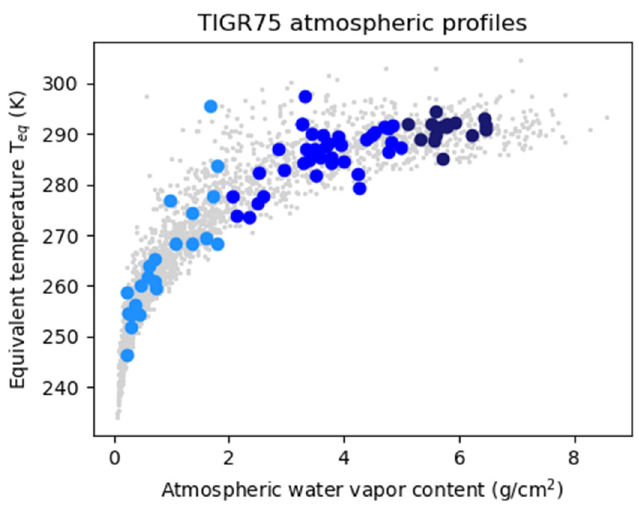
Figure 8. Distribution in the equivalent temperature ( 𝐓 𝐞𝐪 ) and AWVC plan of the TIGR profiles. The grey dots show the original 2311 TIGR profiles, and the blue ones the 75 used in this study. The three shades of blue show water vapor contents in three different categories : AWVC < 2 g/cm 2 , 2 g/cm 2 < AWVC < 5 g/cm 2 , and AWVC > 5 g/cm 2 .